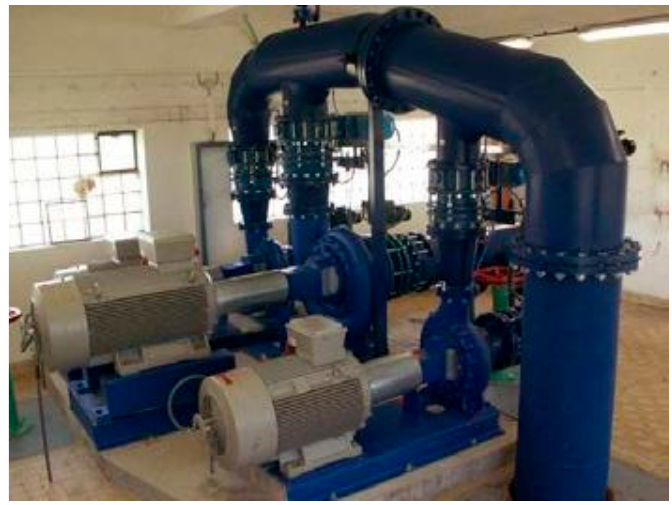
Figure 5. SHPP on a duct feeding untreated water into the water treatment plant [40].